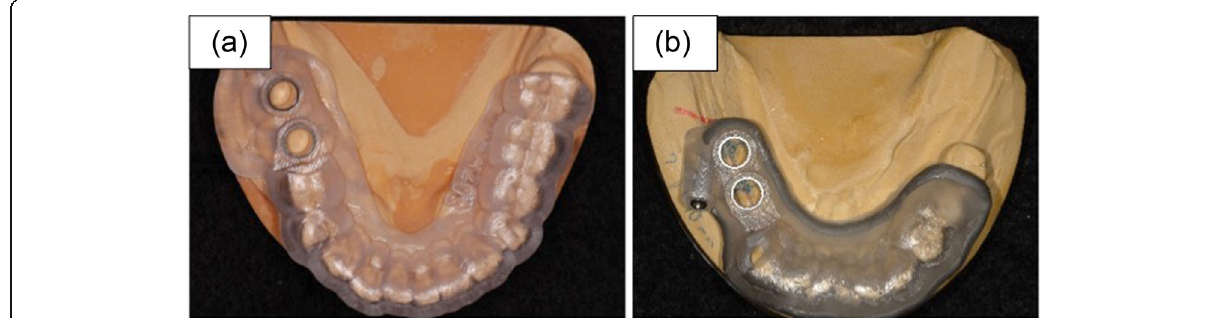
Fig. 5 Example of guide design-derived factors. a The number of teeth supporting the surgical guide: 12 teeth, number of anchor pins: 0, and presence or absence of a reinforcement structure: absence. b The number of teeth supporting the surgical guide: 9 teeth, number of anchor pins: 1, and presence or absence of a reinforcement structure: presence